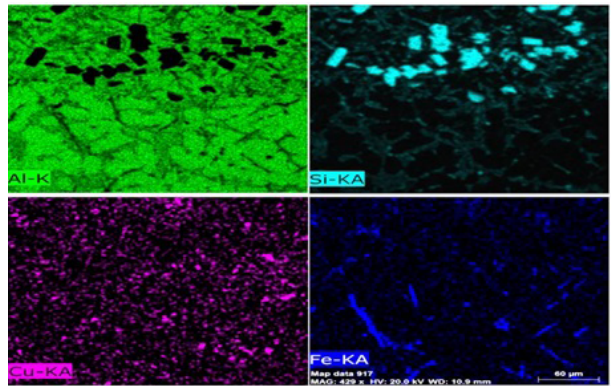
Figure 8. Concentration mappings of Al, Si, Cu and Fe in Fig. 7a of the bimetal casting interface using a 10s time interval.